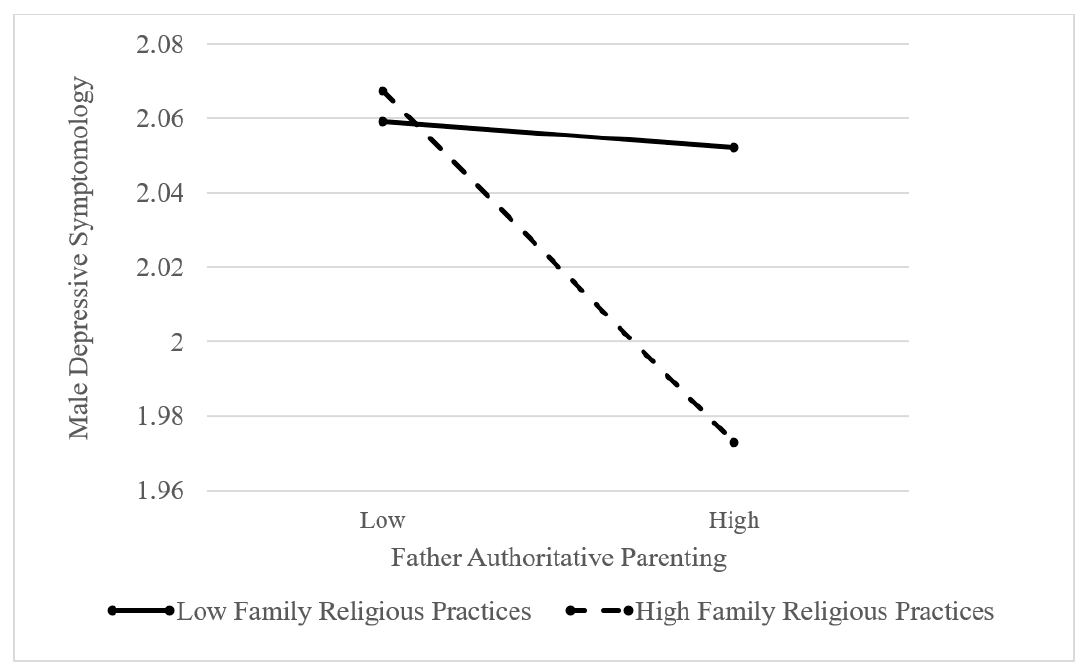
Figure 1. Interaction between paternal authoritative parenting and family religious practices for male teens.